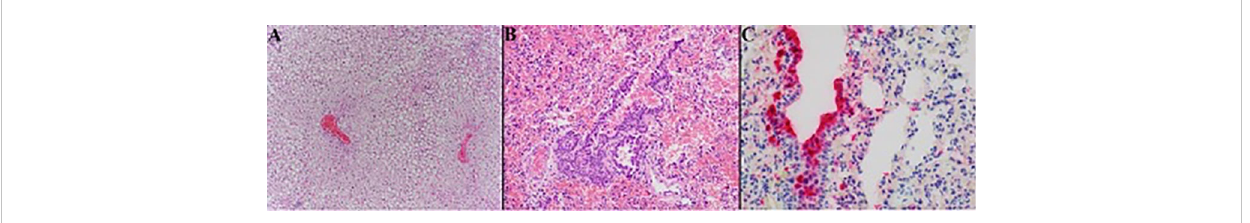
FIGURE 5 Photomicrographs of California mouse liver and pulmonary lesions. A single California mouse became moribund and at necropsy was found to have hepatomegaly. Histopathology showed severe diffuse distention of hepatocytes by lipid vacuoles consistent with hepatic lipidosis (A) 200x). The lungs of this animal exhibited only minimal to mild lymphohistiocytic pneumonia with moderate hyperplasia of the bronchiolar epithelium [ (B) , 200x] but there was marked anti-SARS-CoV-2 positive labeling (red) of hyperplastic bronchial epithelium and histiocytes [ (C) , 400x]. Hematoxylin